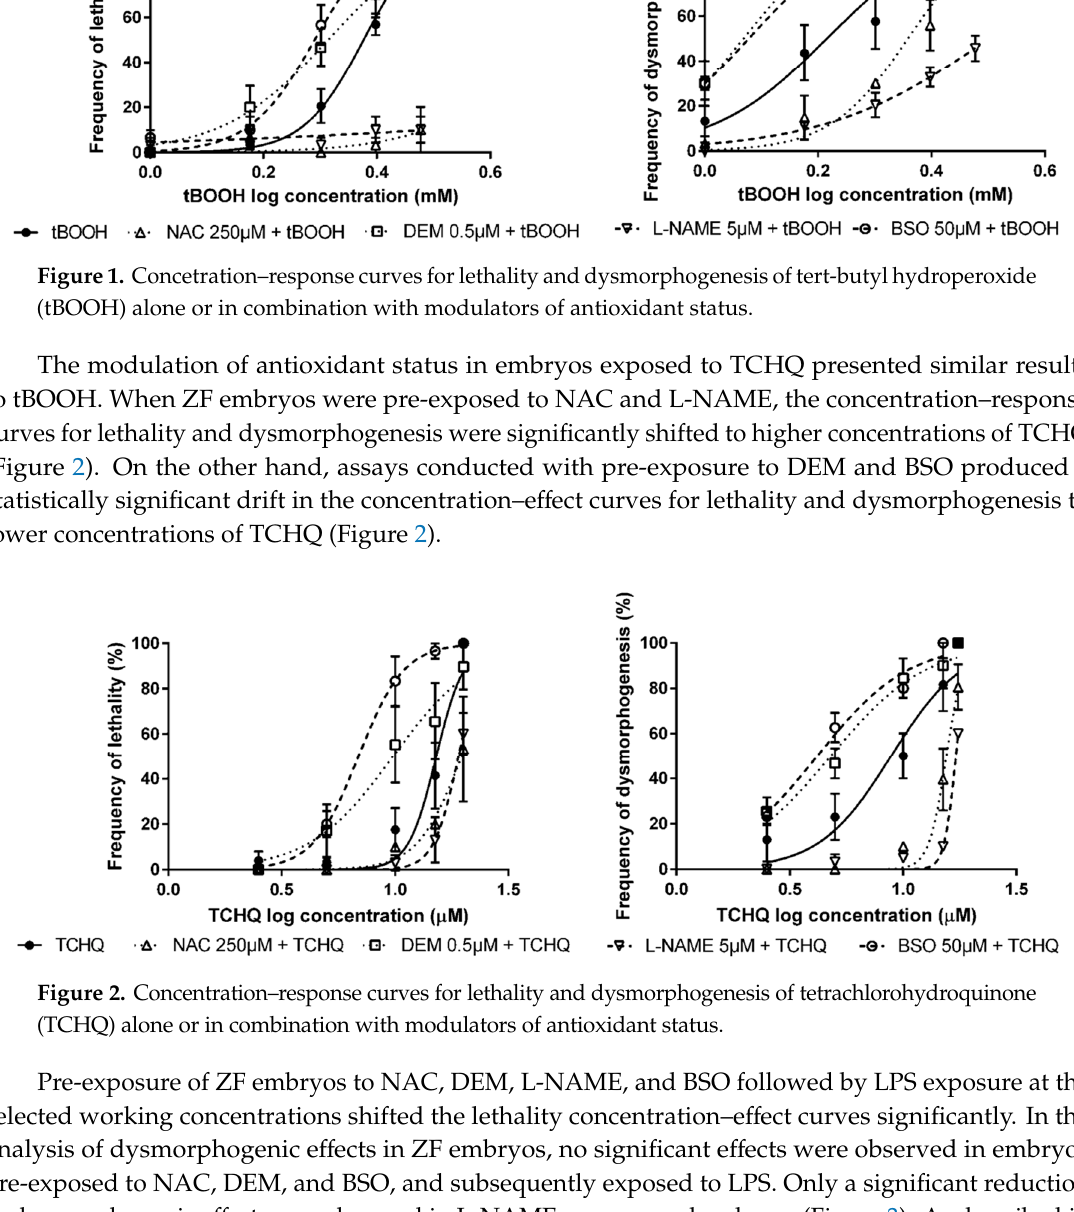
Figure 3. Concentration–response curves for lethality and dysmorphogenesis of lipopolysaccharides of Escherichia coli 0111:B4 (LPS) alone or in combination with modulators of antioxidant status. The modulation of antioxidant status in embryos exposed to tBOOH produced more consistent results than other OS inducers. The observed effects in the embryonic development were general alterations not compound-specific. tBOOH was selected as the general OS inducer for the study of protective effects of antioxidant compounds.